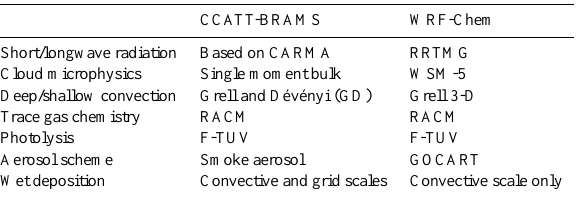
Table 1. CCATT-BRAMS and WRF-Chem physics and chemistry options for the BARCA simulations.